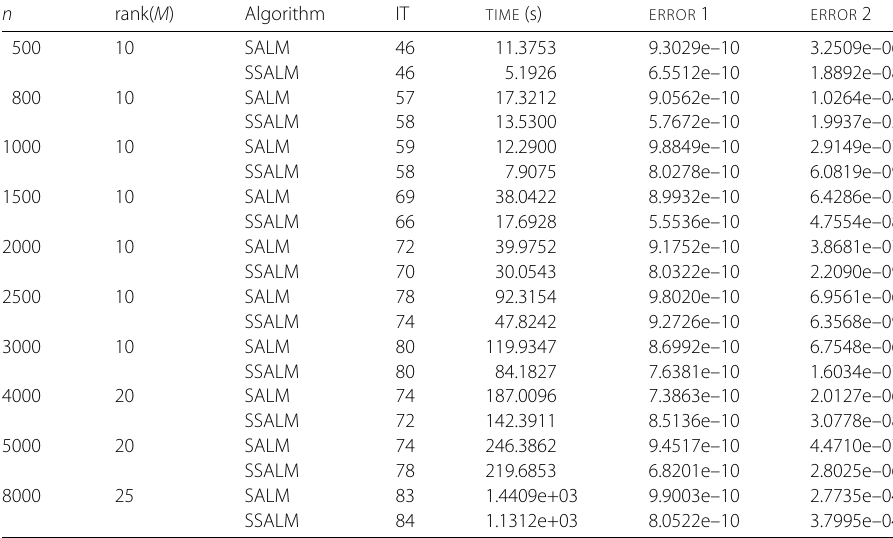
Table 4 Comparison between SALM and SSALM for p =